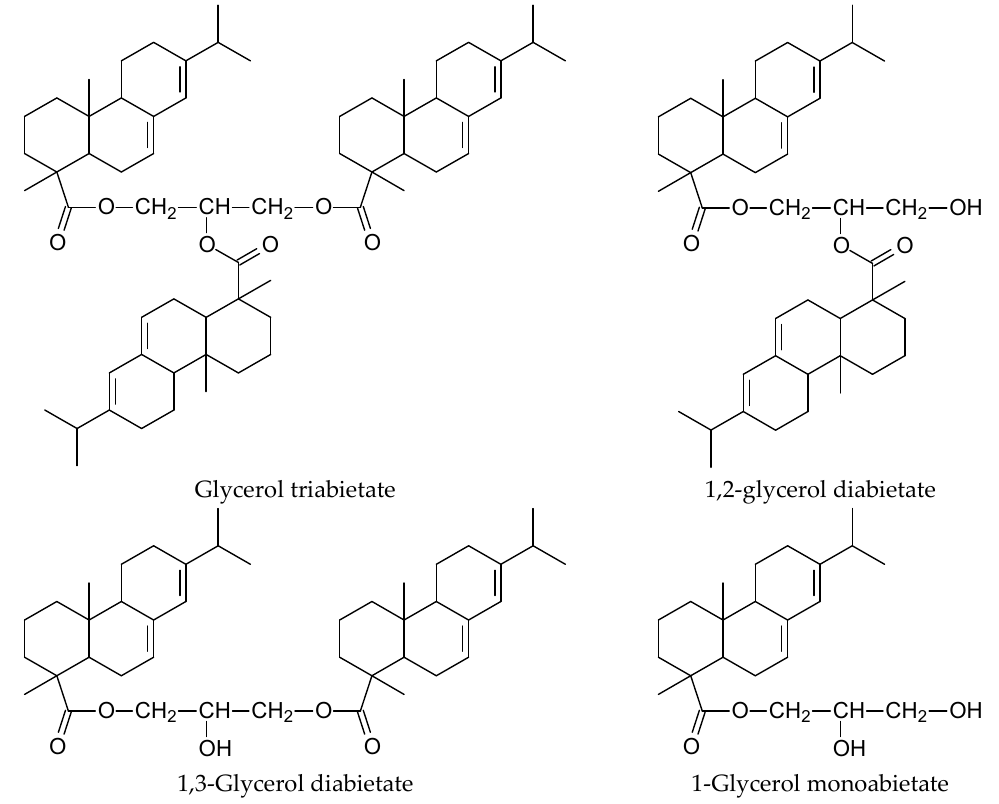
Figure 3. Molecular structures of the main components in commercially available ester gum.